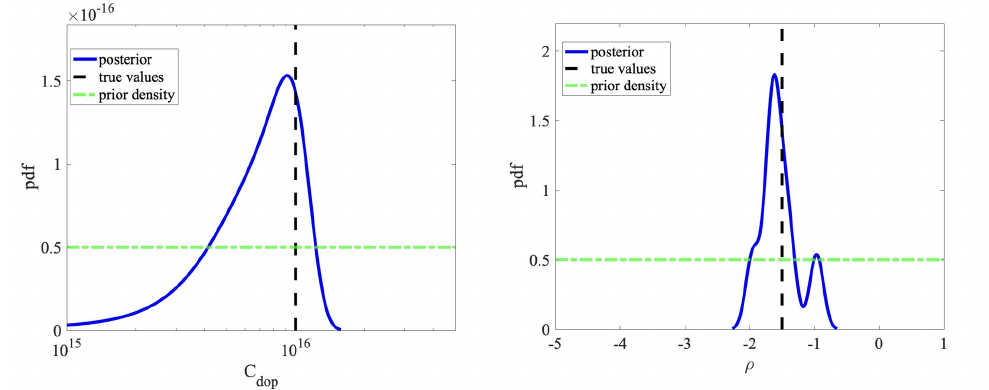
Figure 7. The posterior density of doping concentration ( left ) and surface charge density ( right ) using EnKF-MCMC. The units are C dop (cm 3 ) and ρ (q/nm 2 ).